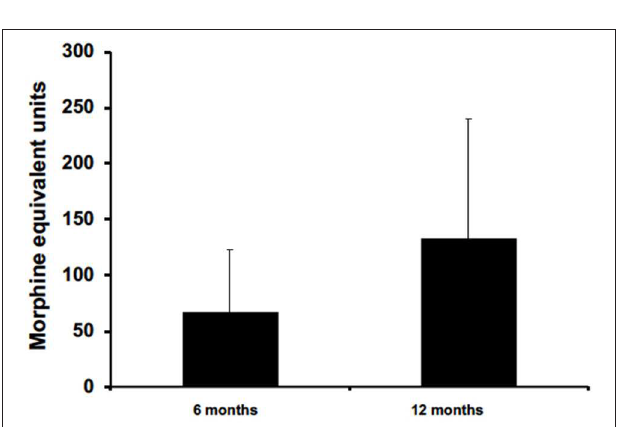
FIGURE 5 | BoNTA treatment reduced opioid use in a time dependent manner ( n =